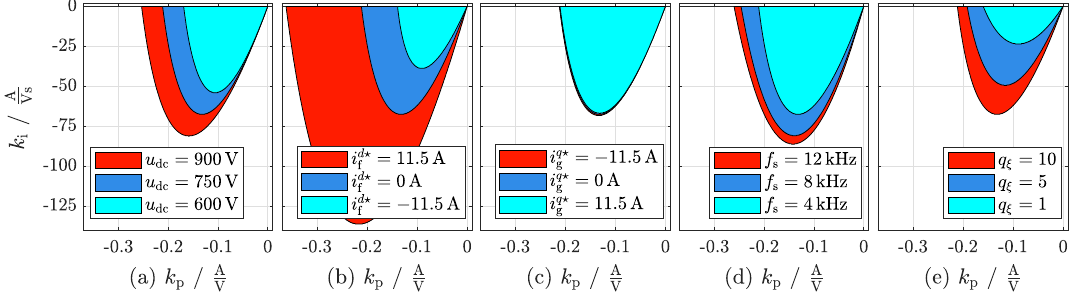
Figure 6. Stable PI voltage controller parameters k i and k p depending on different operating points. (cid:63) ( a ) variation of dc-link voltage u (cid:63) ( b ) variation of filter current i d (cid:63) ( c ) variation of grid current i q g dc f ( d ) variation of sampling frequency f s and ( e ) variation of weighting factor q ξ of integral control action.